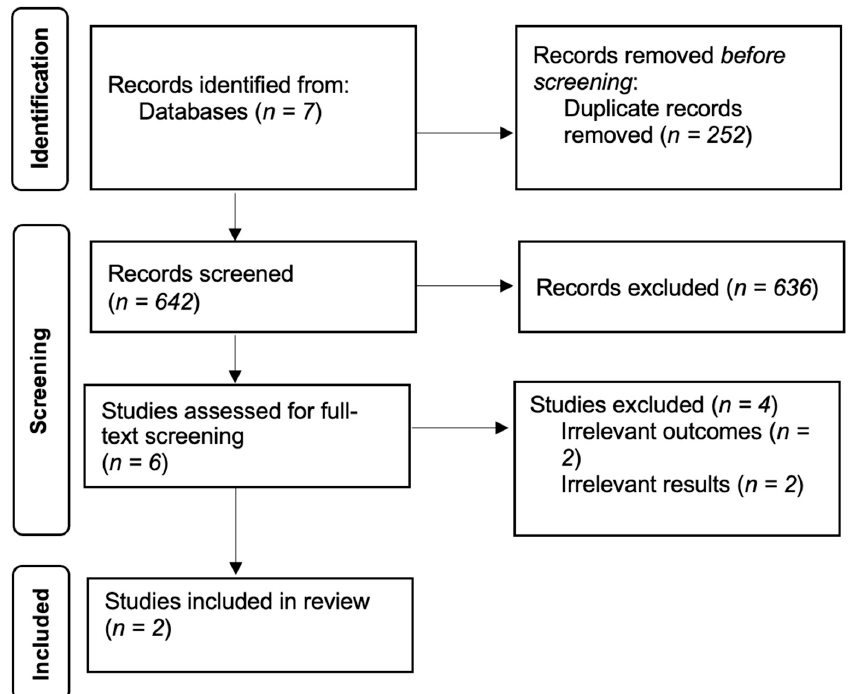
Figure 1. PRISMA flow diagram.